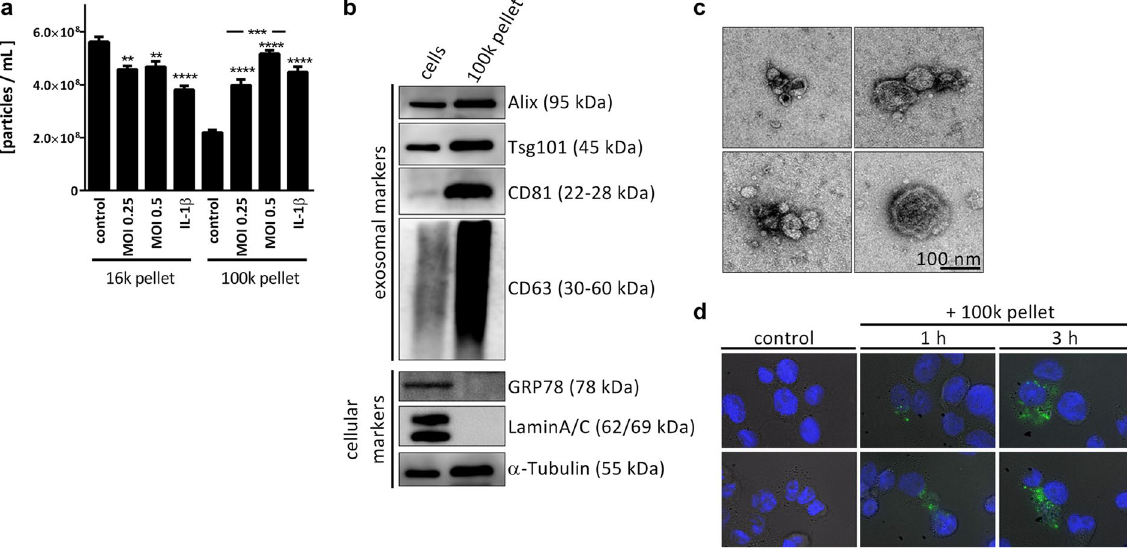
Figure 1. L . pneumophila infection increases the secretion of EVs in THP-1 cells. ( a ) Amount of EVs in response to L . pneumophila infection. THP-1 cells were treated with IL-1 β (1 ng/mL) or infected with L . pneumophila (MOI 0.25 or 0.5, respectively) for 24 h. NTA was performed with the distinct particle fractions separated by differential centrifugation. ( b ) Western blot for exosomal marker proteins. Whole cell lysate or 100 k pellet derived from uninfected THP-1 cells were used. Equal protein amounts were loaded. ( c ) Transmission electron microscopy with 100 k pellet. Purified EVs from THP-1 cells were fixed and visualized after negative staining with uranyl acetate. Scale bar represents 100 nm. ( d ) Uptake of A549-derived EVs by THP-1 cells. A549 cells were stained with the membrane dye PKH67. EVs were collected (100 k pellet) and incubated with THP-1 cells for 1 or 3 h, respectively. Nuclei were stained by DAPI and pictures were taken with an original magnification of 630x. A: Data are shown as mean + SEM of three independent experiments. ** p < 0.01, *** p < 0.001, **** p < 0.0001. B–D: representative